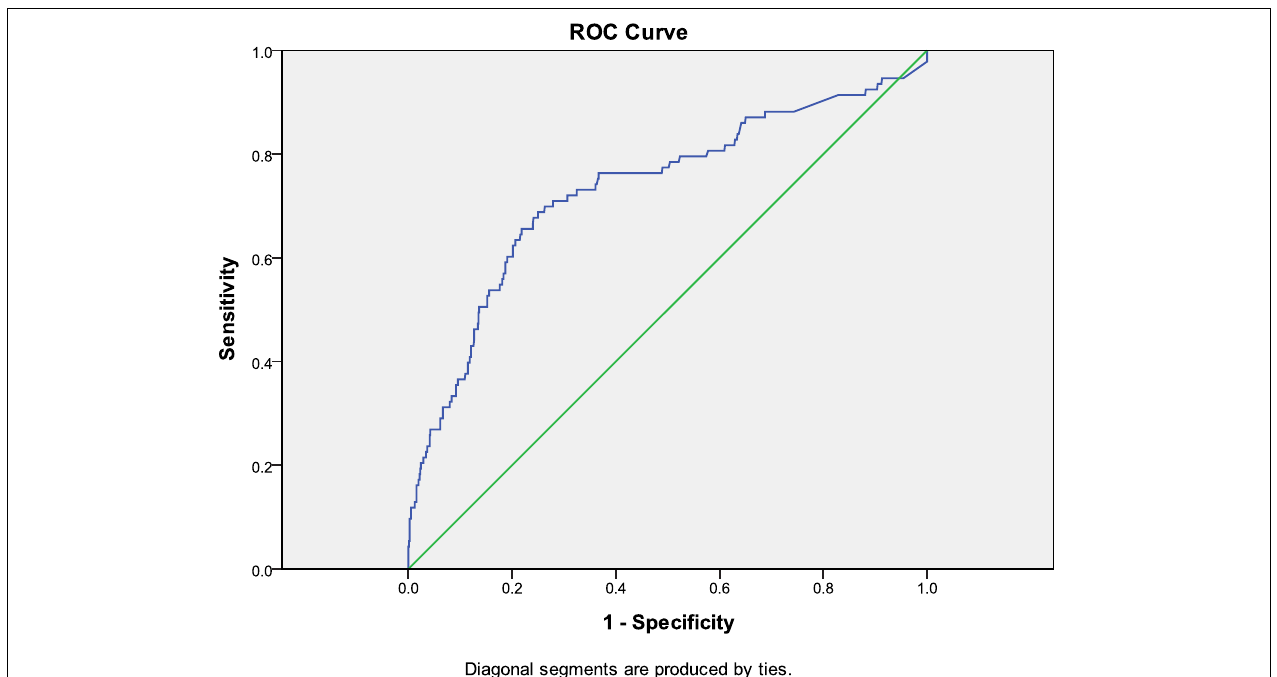
FIGURE 1 | ROC curve in diagnosis of children DHF with BNP cut-off value as 100 pg/ml.